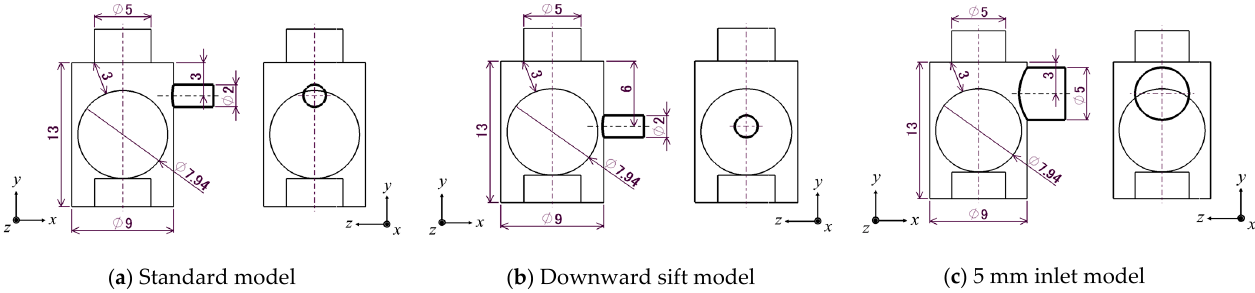
Figure 3. CAE models. Model ( a ) Standard model; Model ( b ) Downward sift model; Model ( c ) 5mm inlet model.